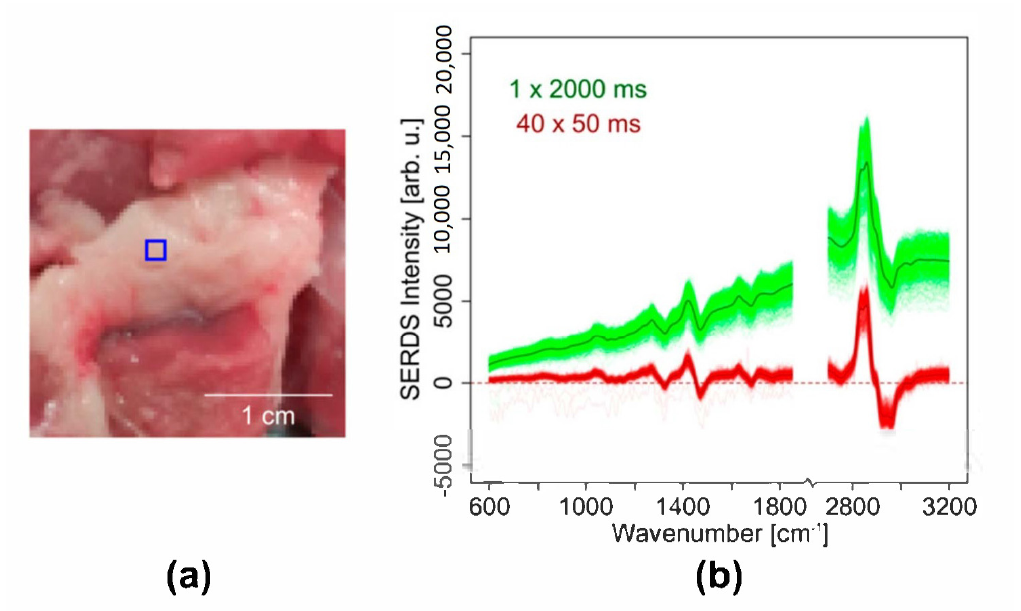
Figure 7. Compensation of photobleaching in SERDS imaging of the fat region of a pork chop using nod and shu ffl e: ( a ) image of the pork chop sample with measurement area marked by a blue square; ( b ) SERDS spectra of the SERDS image (red) with an acquisition time of 50 ms and 40 accumulations, SERDS spectra of the SERDS image (green) with an acquisition time of 2000 ms in a single accumulation. The darker lines (dark green and dark red, respectively) show the mean SERDS spectra of the respective SERDS image. The total exposure time is 4 s for each di ff erence spectrum (2 s for each excitation